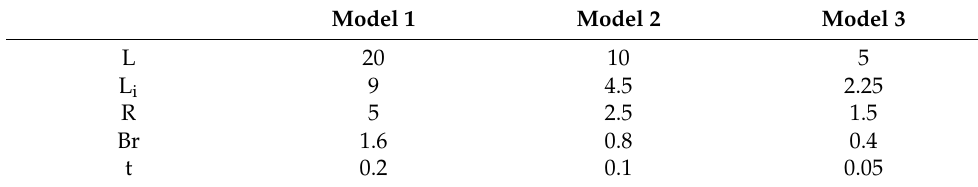
Figure 1. ( a ) Stretch module of the flange with a square hole; ( b ) stainless steel sheet with a square hole. Table 3. Parameters and dimensions of the flange. (unit: mm). Table 4. Mechanical properties and material parameters of SUS304 stainless steel.